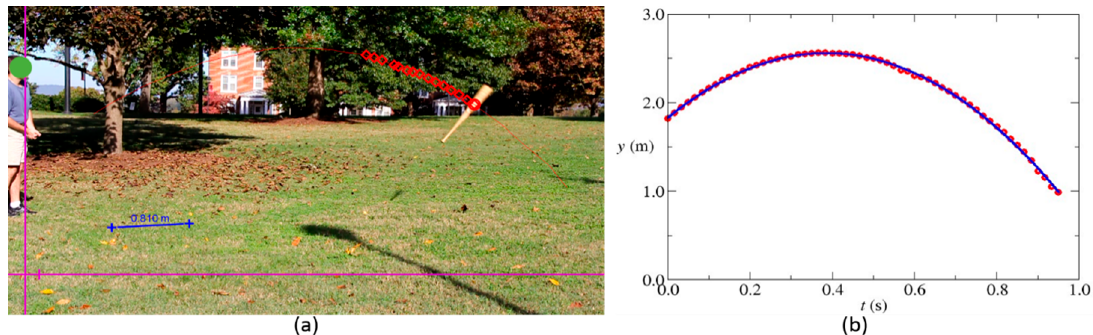
Figure 1. ( a ) Baseball bat tossed with rotation; ( b ) the vertical position of the bat’s centre of mass vs.